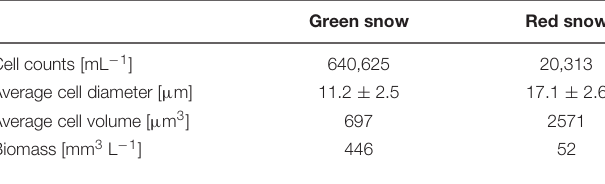
TABLE 1 | Cell counts, average cell sizes, and overall biomass for green and red